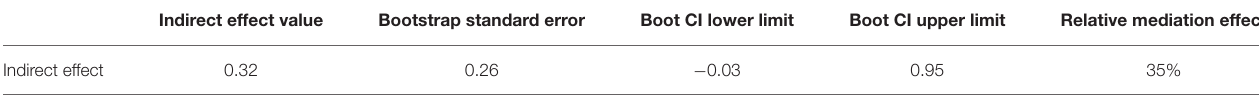
TABLE 2 | The mediating effect of perceived social